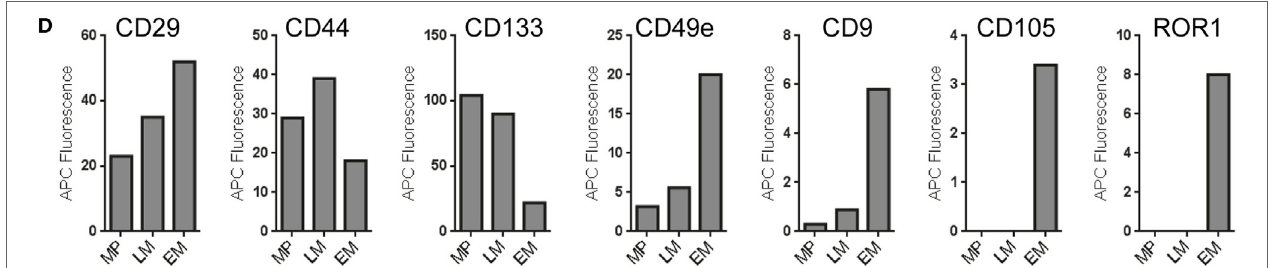
FigUre 10 | Analysis of extracellular vesicles (EVs) secreted by subsets of human hematopoietic stem/progenitor cells. (a) Human umbilical cord blood- derived hematopoietic stem and progenitor cell (HSPC) subtypes were purified via flow cytometric cell sorting, seeded in 48-well plate at doses of 25,000 cells per well in 300 µL medium and cultured for 4 days before supernatants were harvested, pre-cleared by centrifugation, and analyzed in the multiplex bead-based assay. Medium controls were included for all conditions and treated exactly like samples. (B) Dot plots showing raw data for medium control and supernatants from multipotent (MP), lympho-myeloid (LM), and erythromyeloid (EM) HSPC subset-derived supernatants. (c) EV surface signatures for EVs from the three HSPC subsets, background corrected by subtraction of medium control. (D) Expression of selected markers detected in conditioned medium derived from the HSPC subsets. Data from one out of two independent experiments are shown. See Figure S14 and Table S2 in Supplementary Material for further